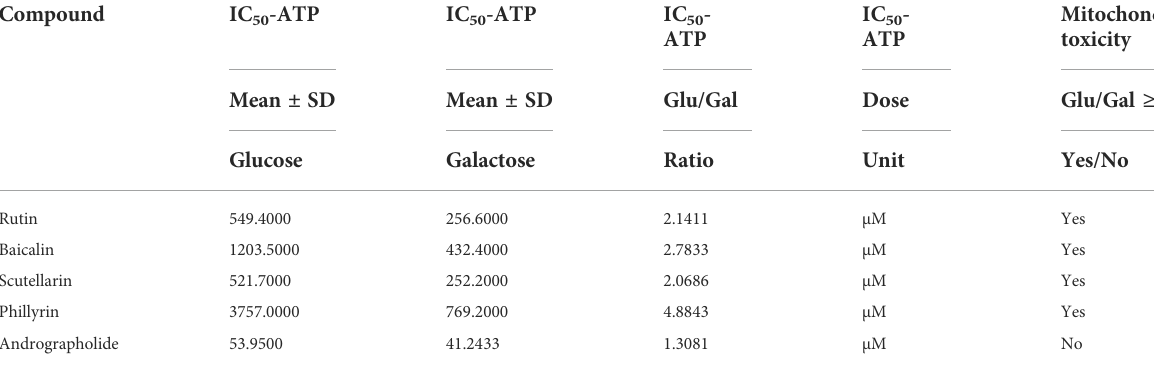
TABLE 5 The effect of ingredients from TCM injections exposure on ATP depletion in HepG2 cells. Compound